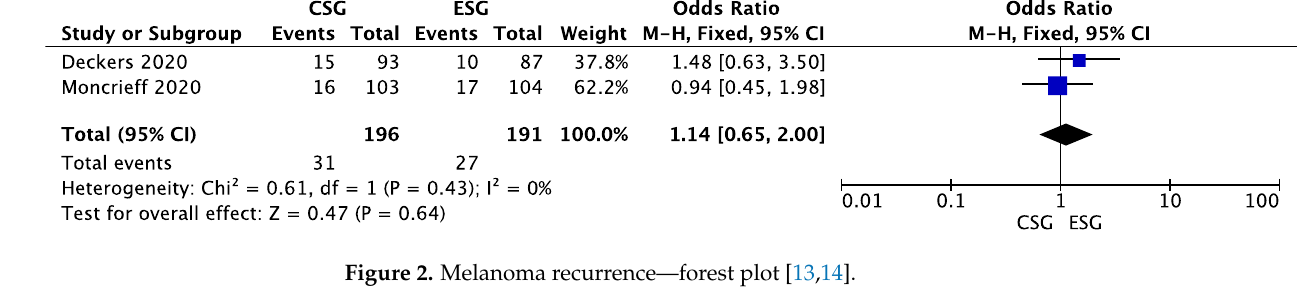
Figure 2. Melanoma recurrence—forest plot.